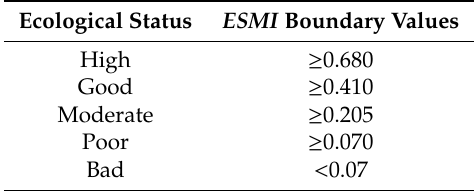
Table 5. Boundary values of the ESMI ecological status assessment index